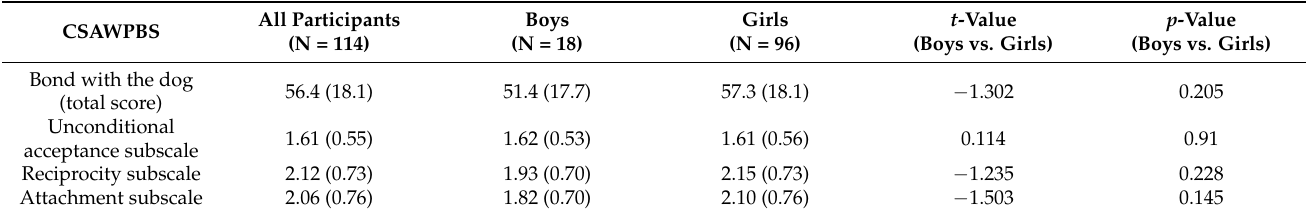
Table 2. Participant–dog bond with the total sample and according to